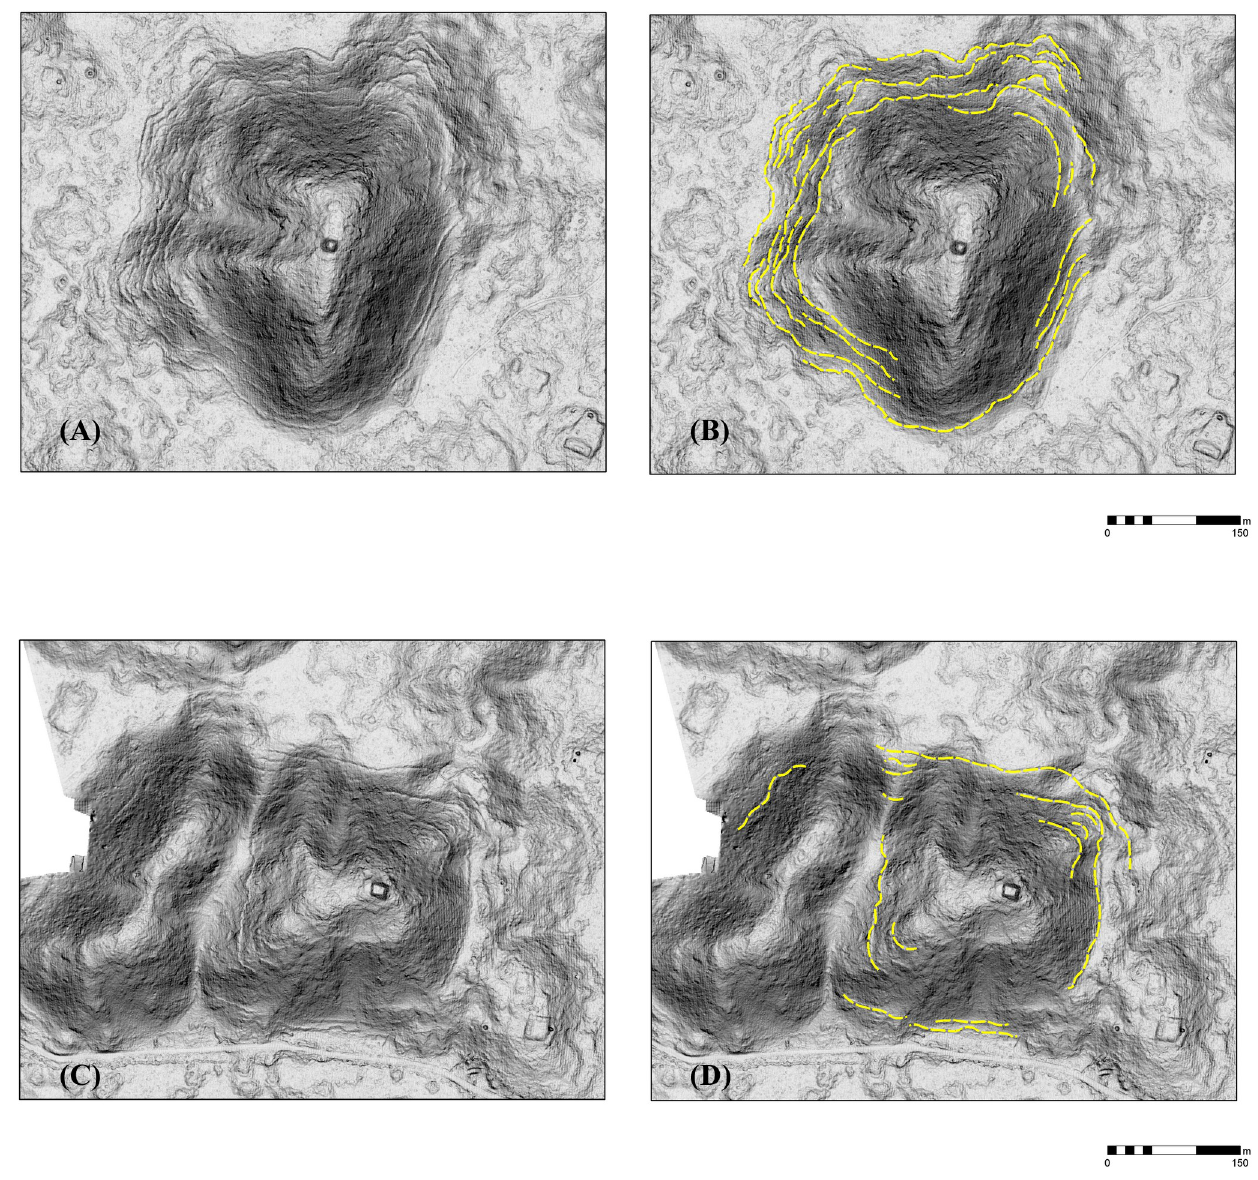
Fig 12. Terracing of Bolonchen cerros. (A, B) Cerro Ku Witz. (C, D) Hill west of Muluchtzekel.